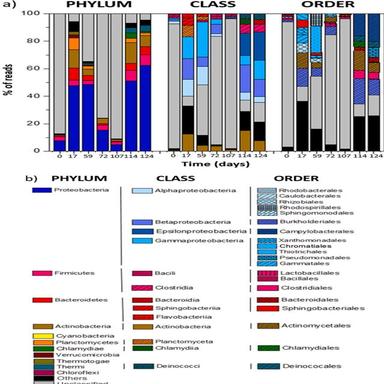
a) Relative abundance of phylum, classes and order along the treatment line. b) Graph legend.